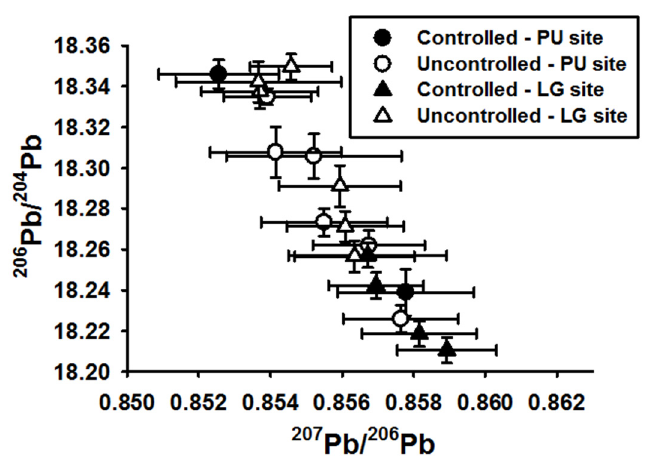
Figure 6. Isotopic composition of the PM 2.5 collected at LG and PU sites during controlled and uncontrolled periods. The error bars represent the standard deviation of the Pb isotopic ratios for all samples.